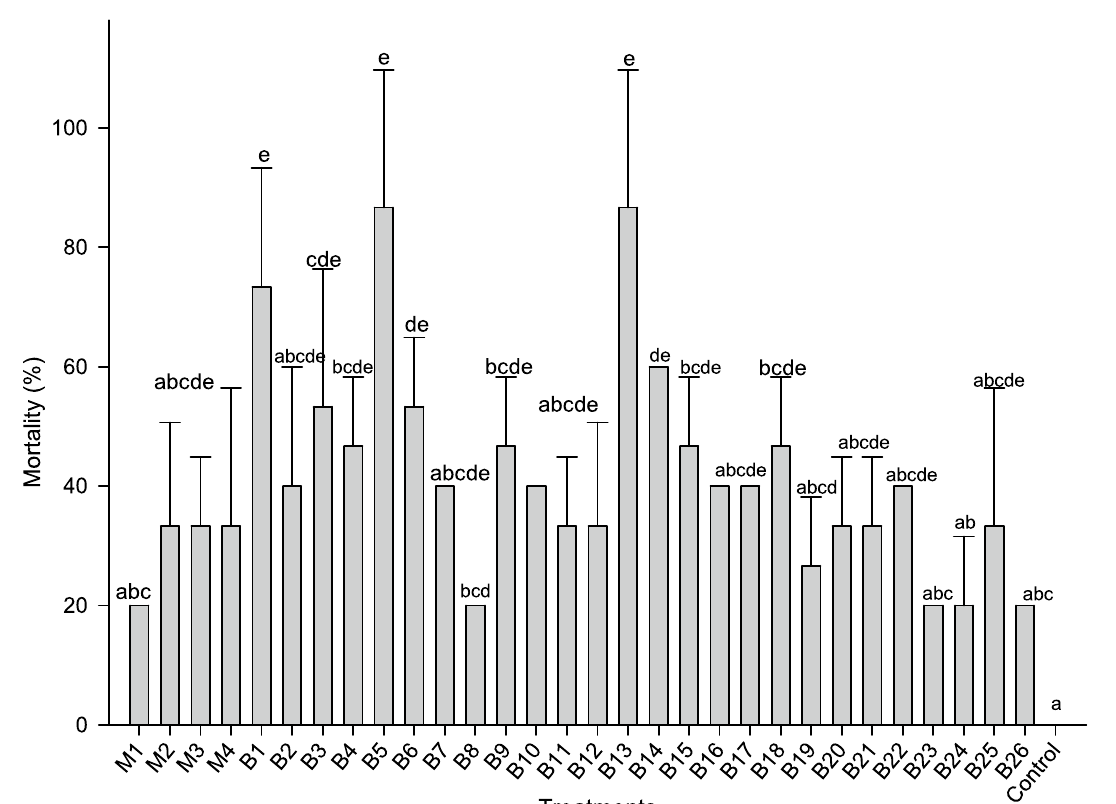
Fig. 1 Pathogenicity of entomopathogenic fungi (EPF) isolates on Cosmopolites sordidus adults. Means with the same letter were non-significantly different ( P < 0.05 Conover’s